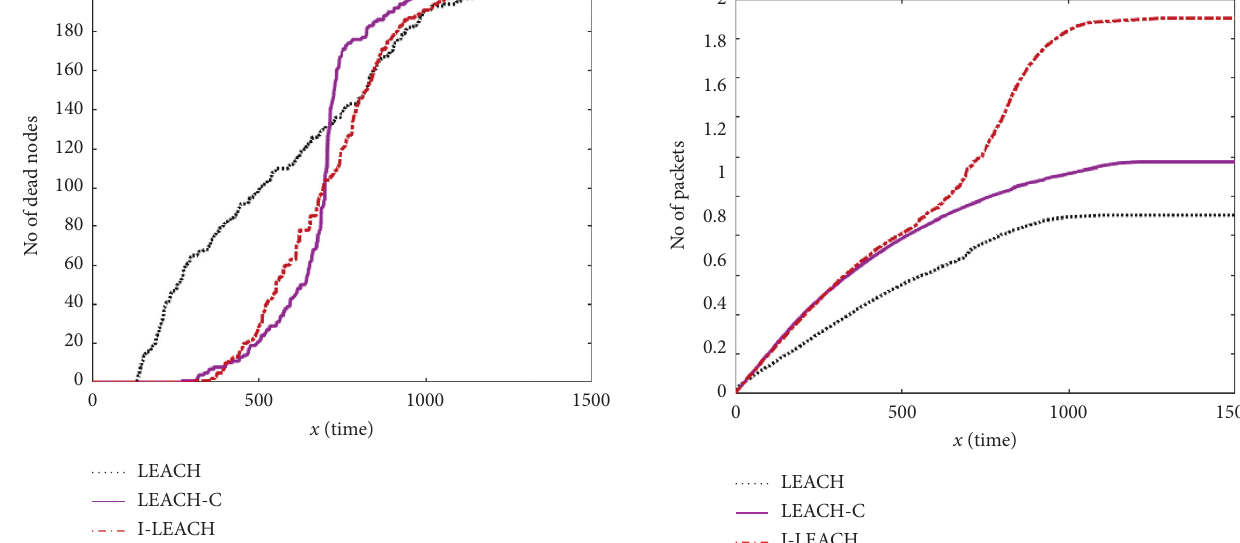
Figure 8: Comparison of the number of packets transmitted under the three protocols.